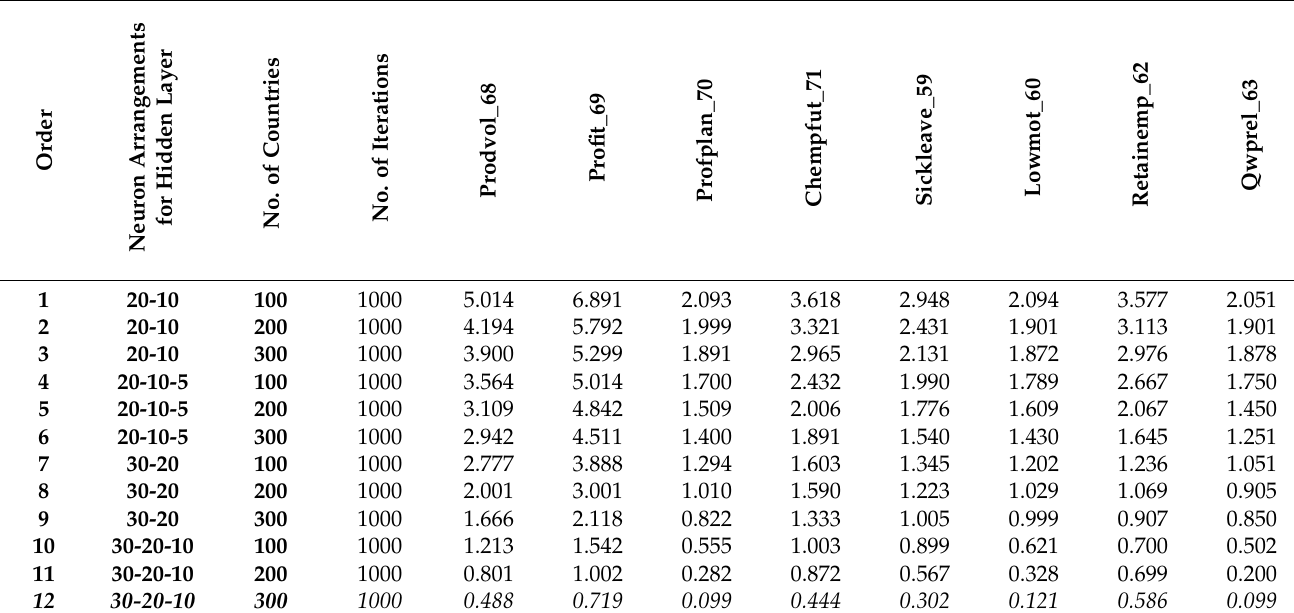
Table 3. Training MAPE for the effect of employee voice on outputs.